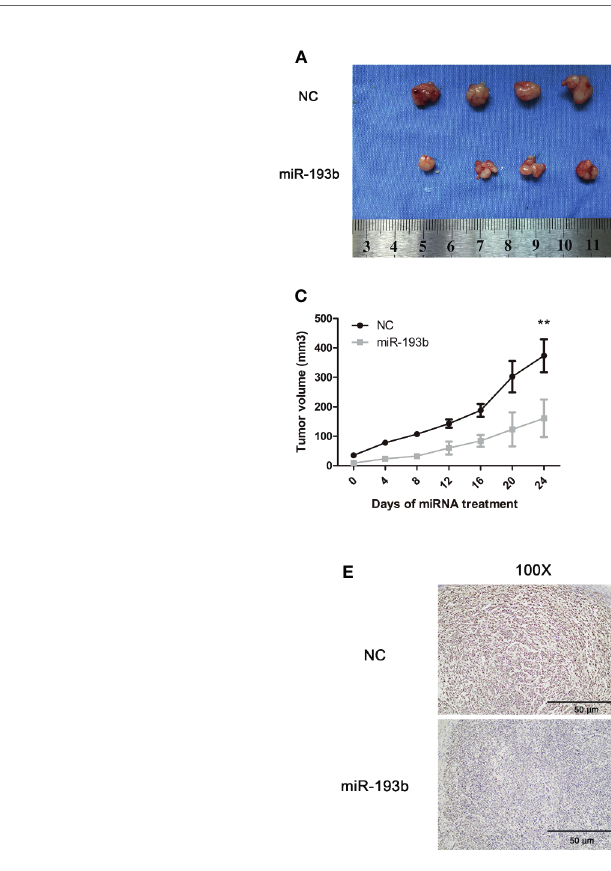
FIGURE 2 | miR-193b suppresses cervical cancer growth in vivo . Subcutaneous Siha tumors located on mice xenograft models were directly injected with miR- 193b for a total of 6 times at 4-day intervals. Tumors were harvested on the 24th day from the injection. (A) miR-193b inhibited cervical cancer growth in vivo . (B) miR-193b expression levels of each group after intratumoral miR-193b injections were measured by qRT-PCR. (C) Effect of miR-193b on tumor growth and tumor volumes. (D) The tumors were weighed after harvested. (E) The protein levels of Ki-67 were detected using IHC. * p < 0.05, ** p < 0.01, *** p <